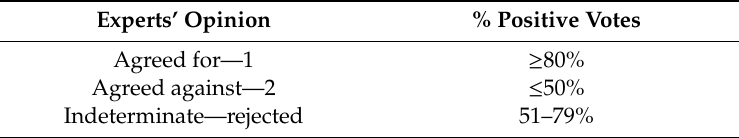
Table 1. Degree of experts’ agreement, Delphi method.